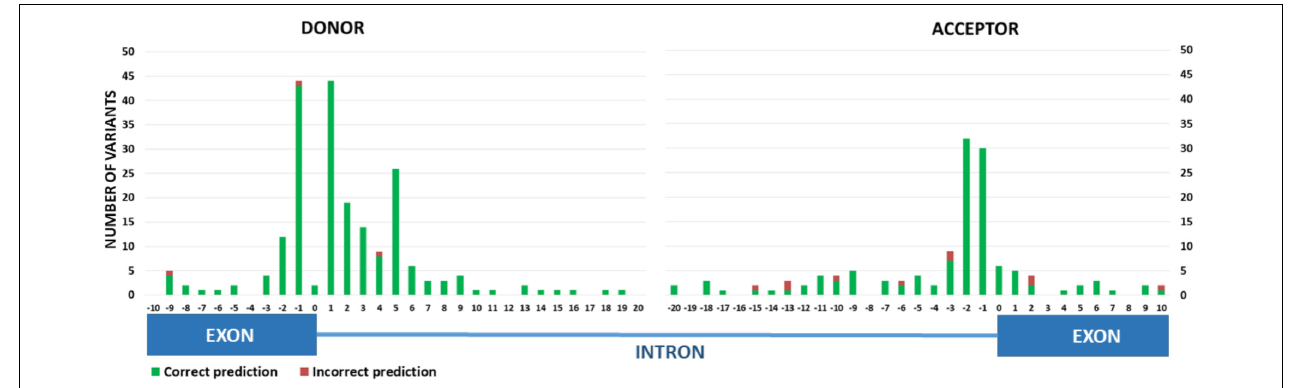
FIGURE 4 | Prediction performance of HSF+SSF-like for donor sites and SSF-like for acceptor sites with variants collected in the validation set. Correct prediction: in silico and in vitro results are concordant. Incorrect prediction: in silico and in vitro results are